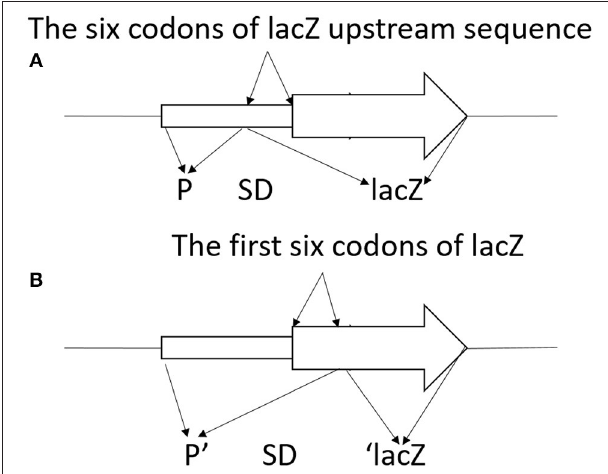
FIGURE 1 | Schematic diagram of lacZ transcriptional fusion (A) and ‘lacZ translational fusion (B) . (A) Transcriptional control of lacZ depended on the x promoter (P). Translational product was a hybrid protein containing some upstream amino acids of X coding region and a functional component of β -galactosidase. Promoter strength and effectiveness of inducing translation of the target gene was reflected by the information of the translational fusion. (B) Translational control of ‘lacZ relied on the x promoter (P). Translational product was a hybrid protein containing some upstream amino acids of X coding region and the first codon of X, as well as a large functional component of β -galactosidase at C-terminal. Promoter strength of the corresponding gene was reflected in the information of the translational